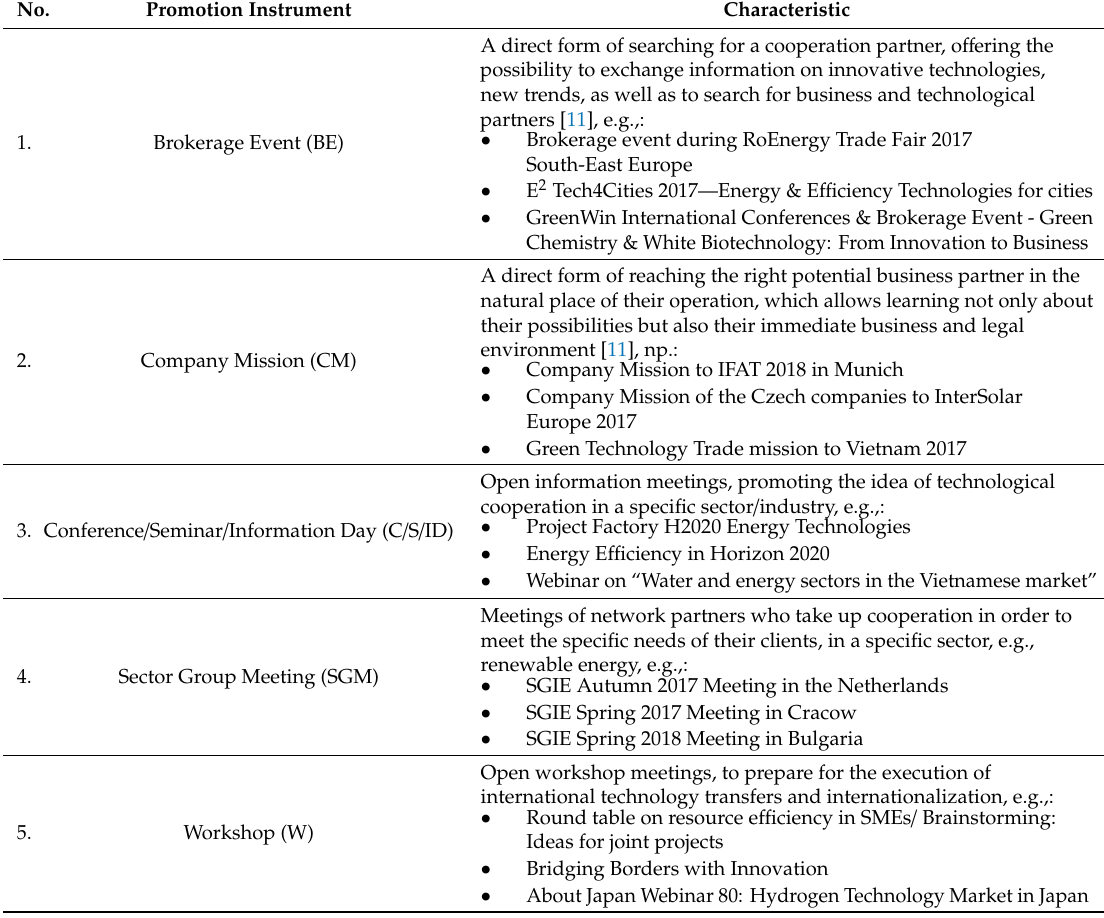
Table 1. The characteristic of events used by the Enterprise Europe Network (EEN)